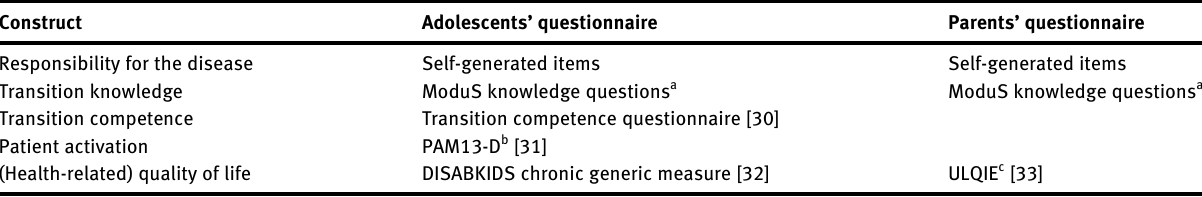
Table  : Questionnaires used to evaluate the “ TraiN ” transition program.